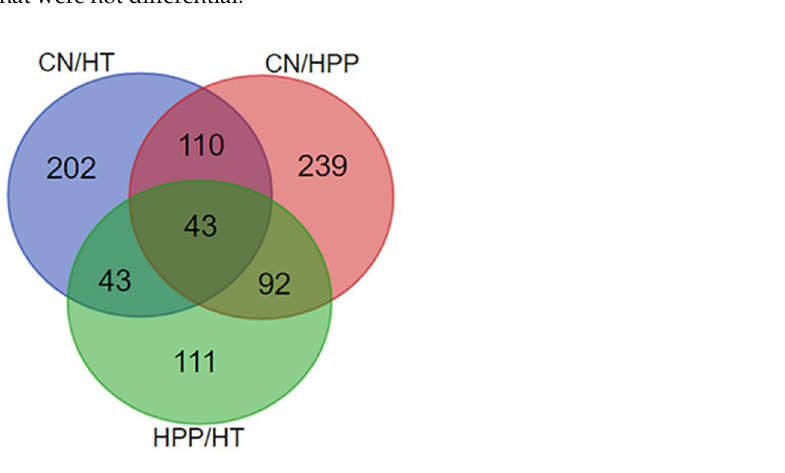
Figure 1. Volcano map of HPP and HT. The red dots in the volcano map represent the up-regulated protein, the green dots represent the down-regulated proteins, and the gray dots represent proteins that were not differential.